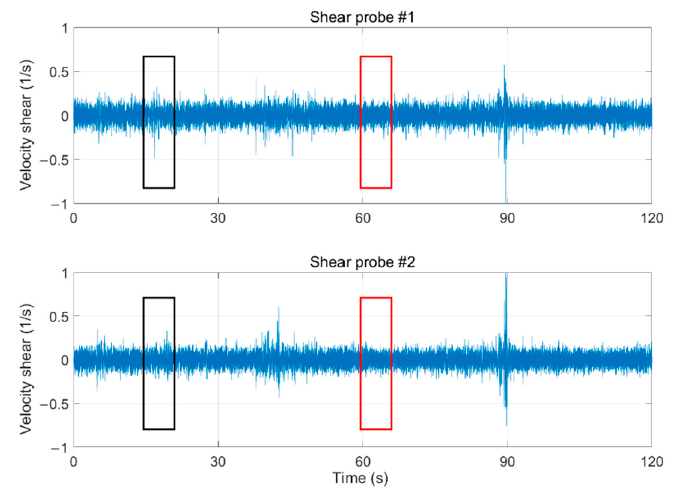
Figure 14. Filtered time series of velocity shear measured by turbulent AUV. The black and red rectangles denote the strong and weak velocity shear region respectively.